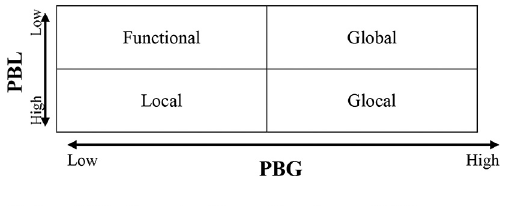
perceived brand globalness and